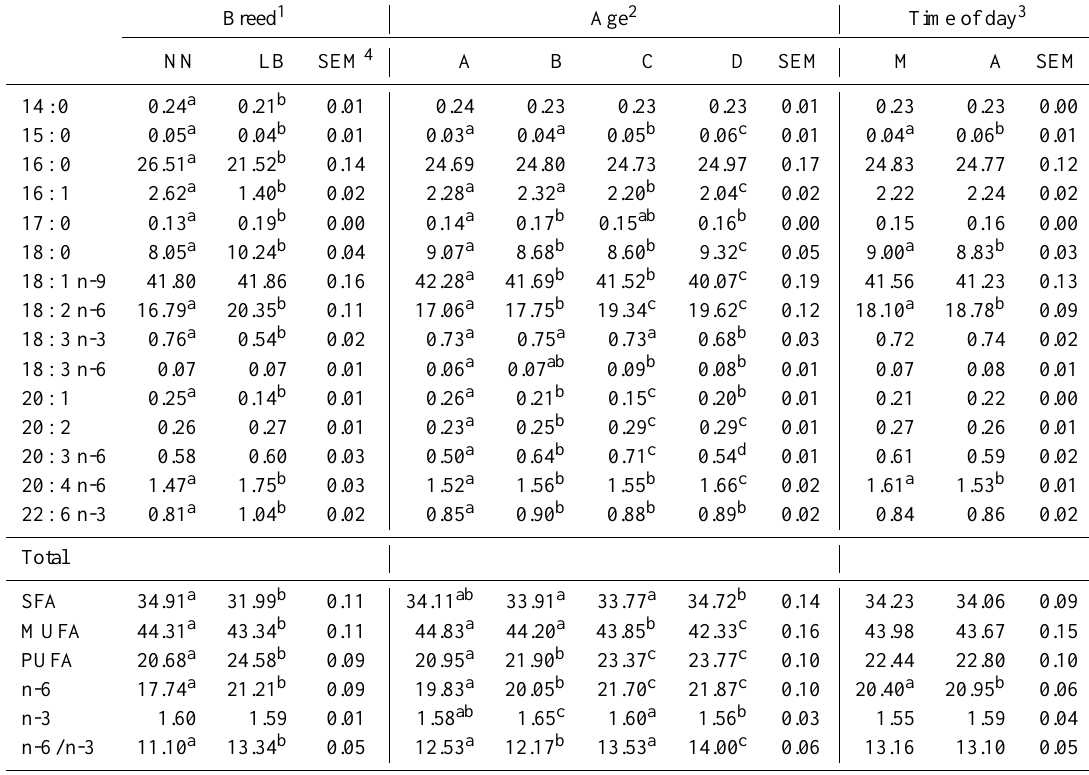
Table 4. Effect of breed, age and time of sampling on fatty acid composition of whole eggs (least square means). Breed 1 Age